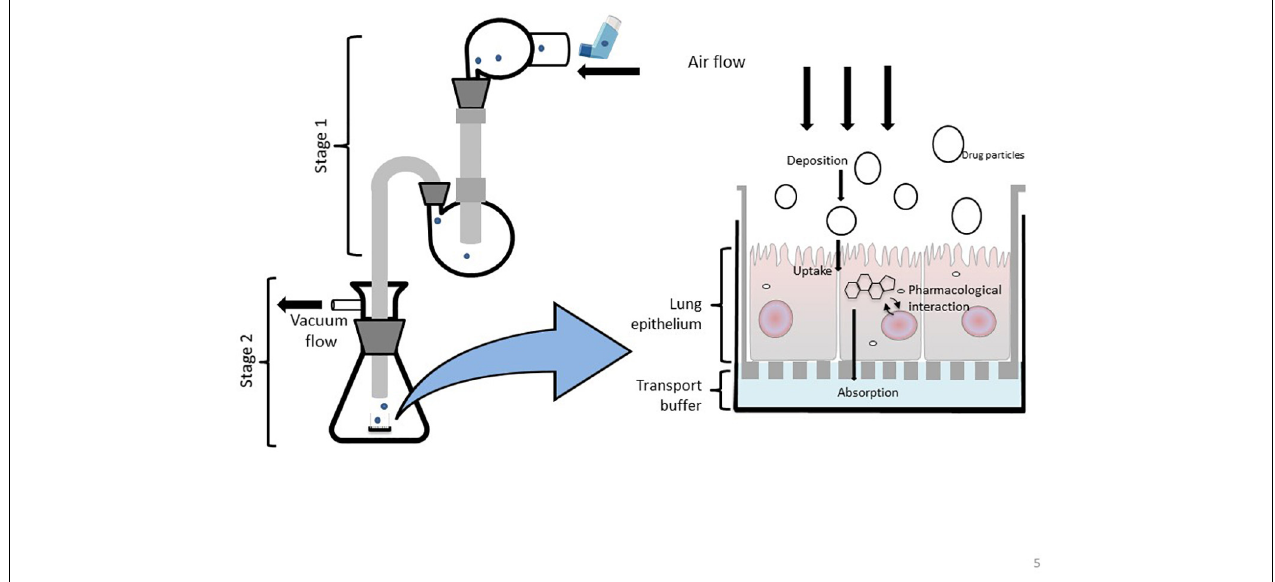
FIGURE 5 | Schematic representation of a modified Twin Stage Impinger (mTSI) with the integration of ALI cell culture insert at the base of stage 2 enabling aerosolized drugs to be deposited directly at the respiratory epithelia to better mimic in vivo biopharmaceutical processes of particle deposition and absorption.